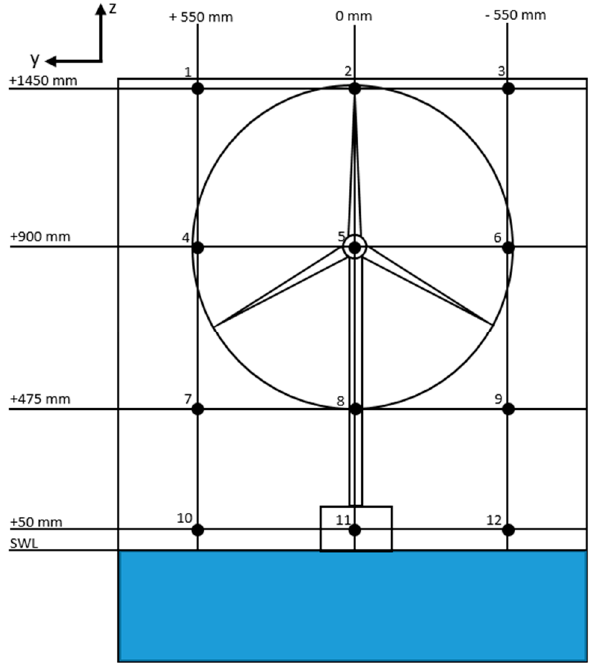
Figure 6. Anemometer recording locations for wind speed calibration.